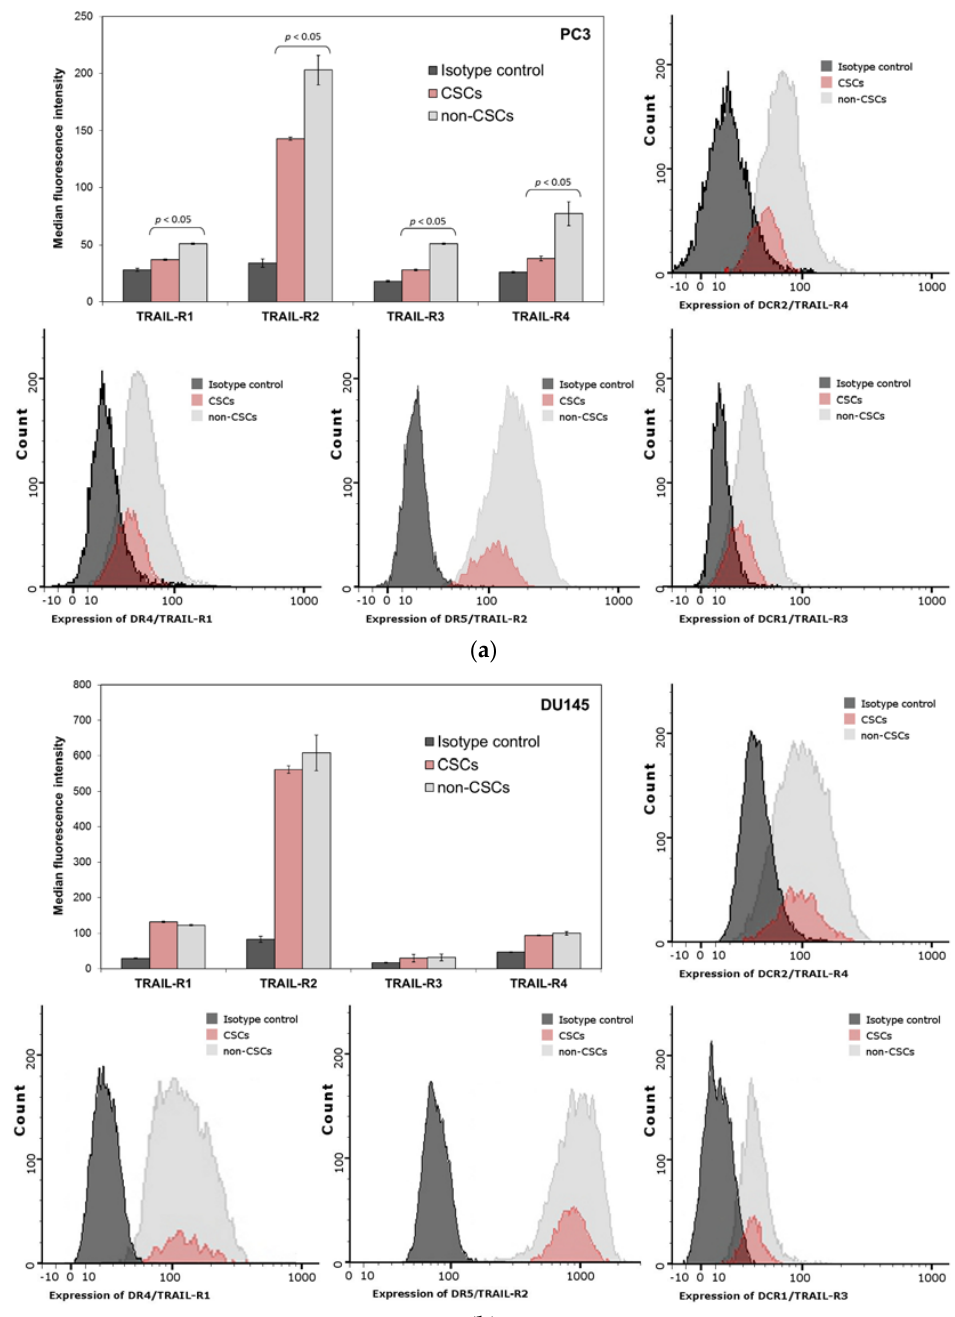
Figure 7. Expression of TRAIL-Receptors (R1, R2, R3 and R4) on the Surface of CSCs and non-CSCs subpopulations within: PC3 ( a ); and DU145 ( b ) prostate cancer cells. The dark grey histogram shows isotype control, red corresponds to CSCs, and light grey histogram shows non-CSCs.